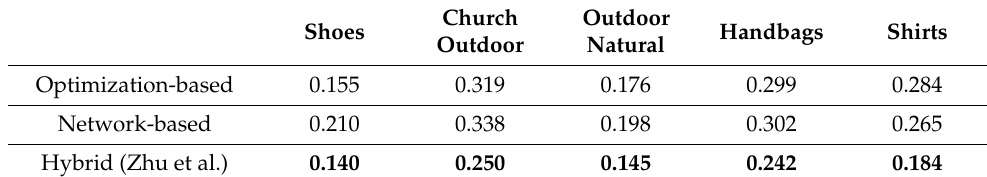
Table 10. Average error measured for image reconstruction per dataset [70].